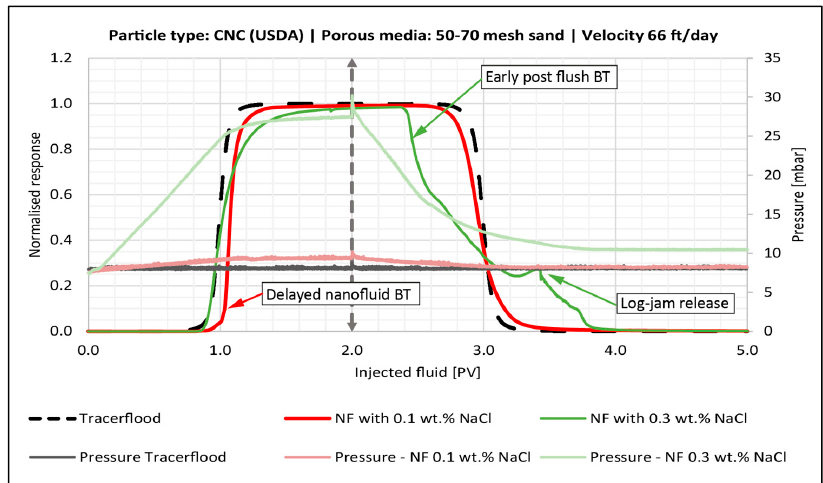
Figure 12. Breakthrough curve for the sandpack flood with 0.5 wt. % CNC (USDA) in 0.1 wt. % NaCl (red line) and 0.3 wt. % NaCl (green line). Dashed vertical line illustrates the switch to post flush fluid. The tracer BT-curve is the black dotted line. The corresponding pressure curves are also shown.